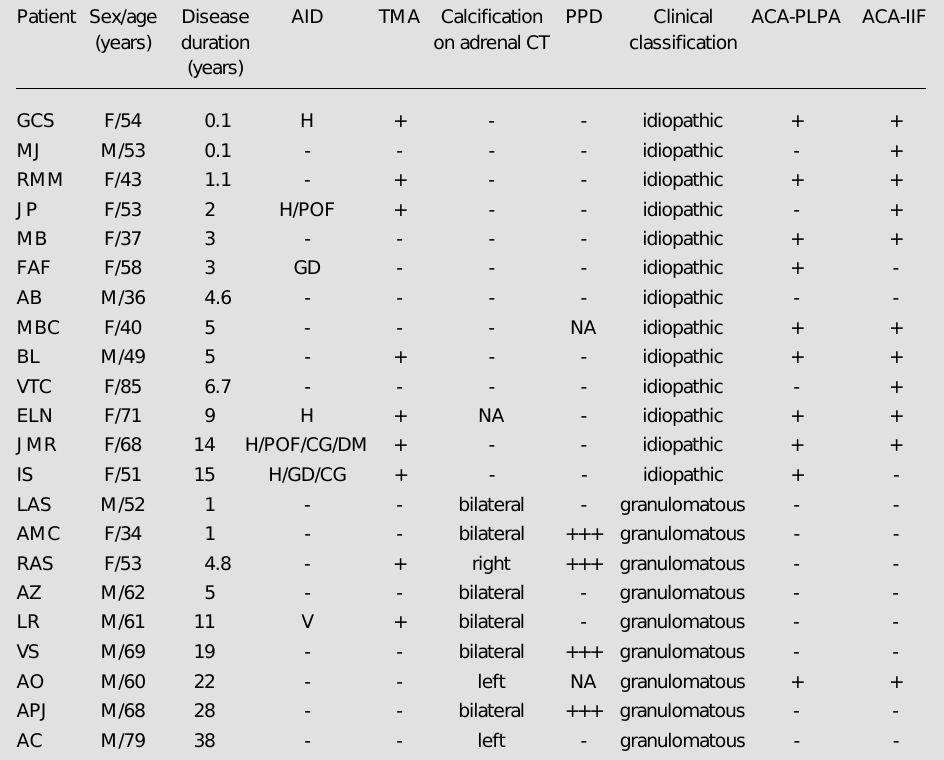
Table 1 - Clinical characteristics of the 22 patients with Addison’s disease. AID: Autoimmune disease clinically manifested (H: Hashimoto’s thyroiditis; GD: Graves’ disease; POF: premature ovarian failure; CG: chronic atrophic gastritis; DM: type 1 diabetes mellitus; V: vitiligo); TMA: thyroid microsomal antibodies; ACA-PLPA: adrenocortical antibodies detected by the peroxidase-labelled protein A technique; ACA-IIF: adrenocortical antibodies detected by indirect immunofluorescence; NA: not available. Patient Sex/age Disease